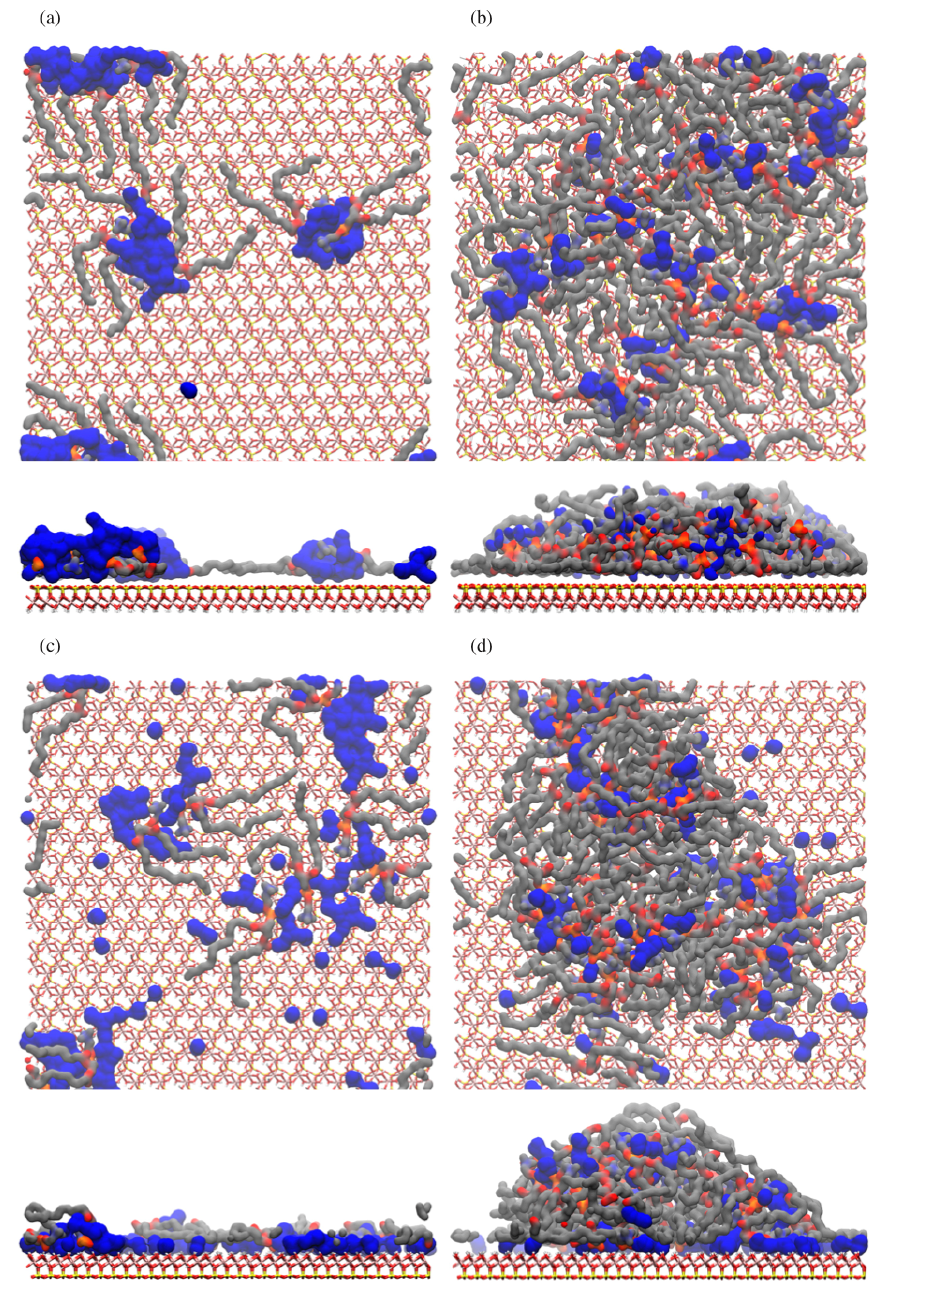
Figure 5. Residual water distribution (emphasized in blue) for hydrophobic siloxane ( a , b ) and hydrophilic alumina ( c , d ) kaolinite surface. The displayed snapshots correspond to moderate ( n = 10) and high ( n = 56) surface